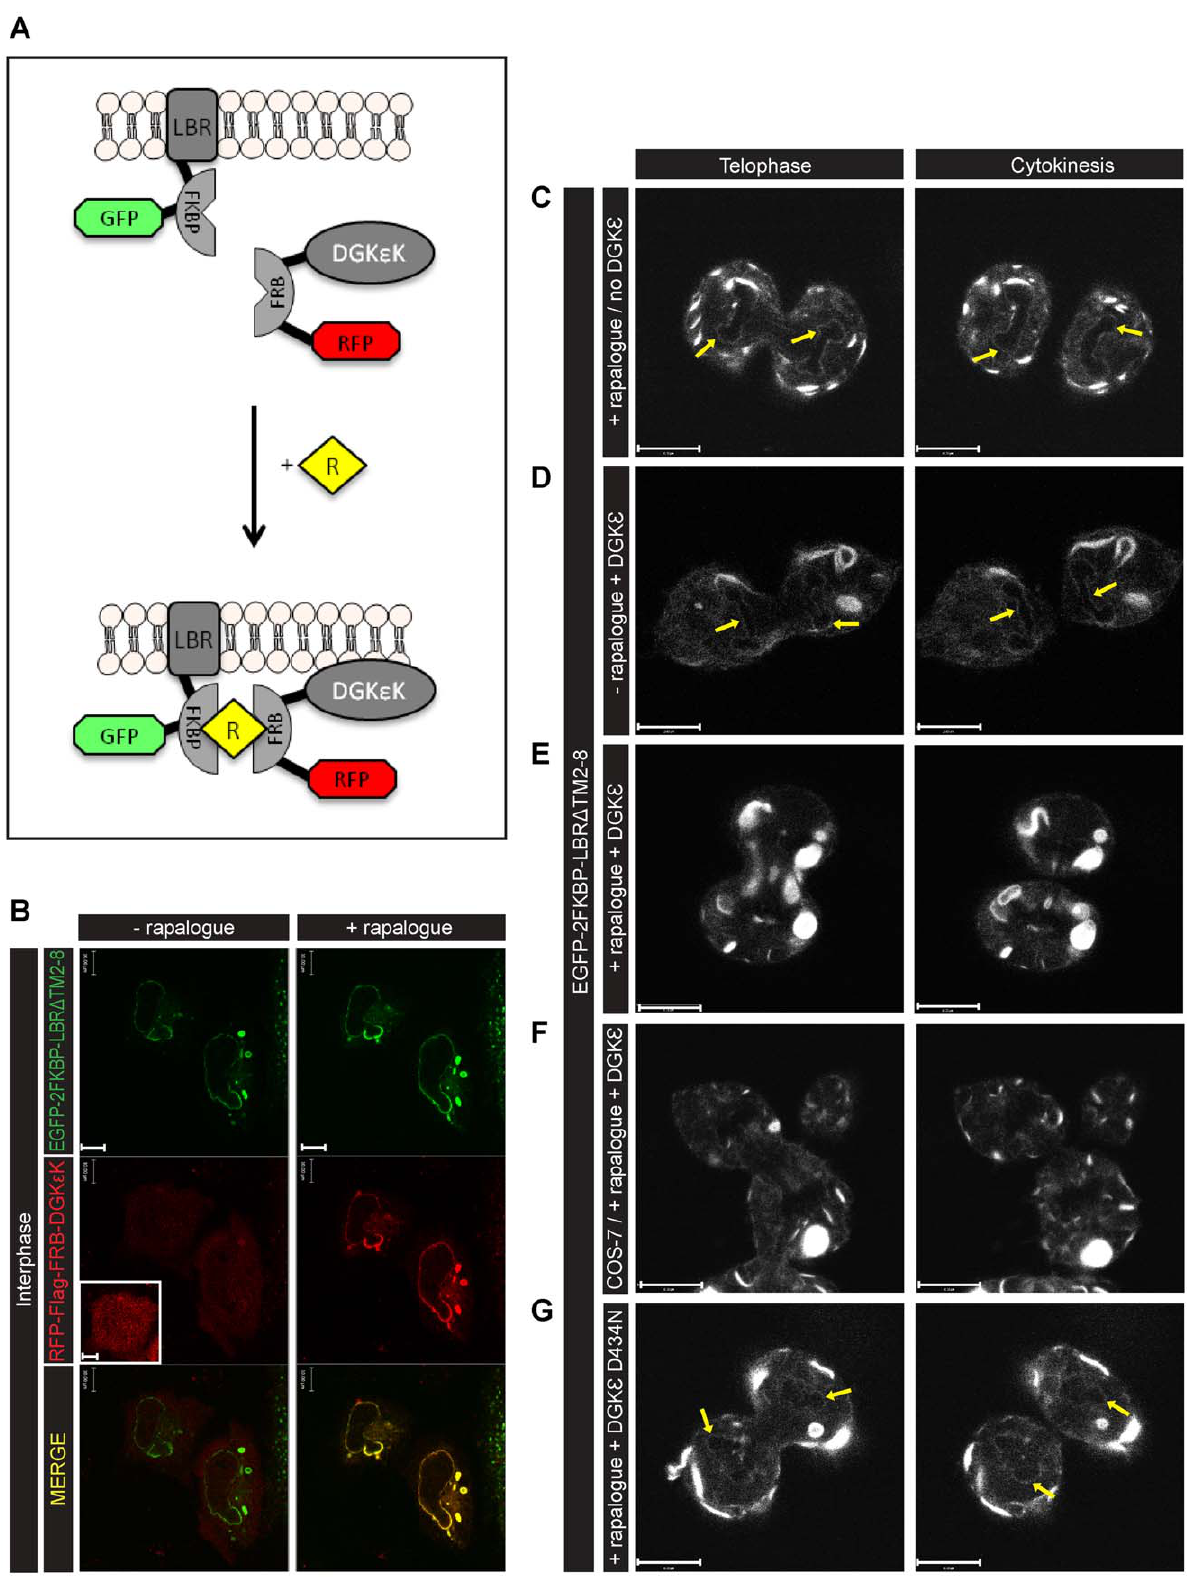
Figure 2. Acute depletion of DAG results in an incomplete NE. (A) Diagram of the rapalogue dimerisation device. After rapalogue (R) treatment, RFP-Flag-FRB-DGK e K (DGK e ) dimerises with EGFP-2FKBP-LBR D TM2-8 (LBR) and is recruited to LBR in the ER and NE. (B) Confocal images of live interphase HeLa cells transfected with LBR (green) and DGK e (red) show the recruitment of DGK e (inset) to the NE and ER, 45 min after addition of